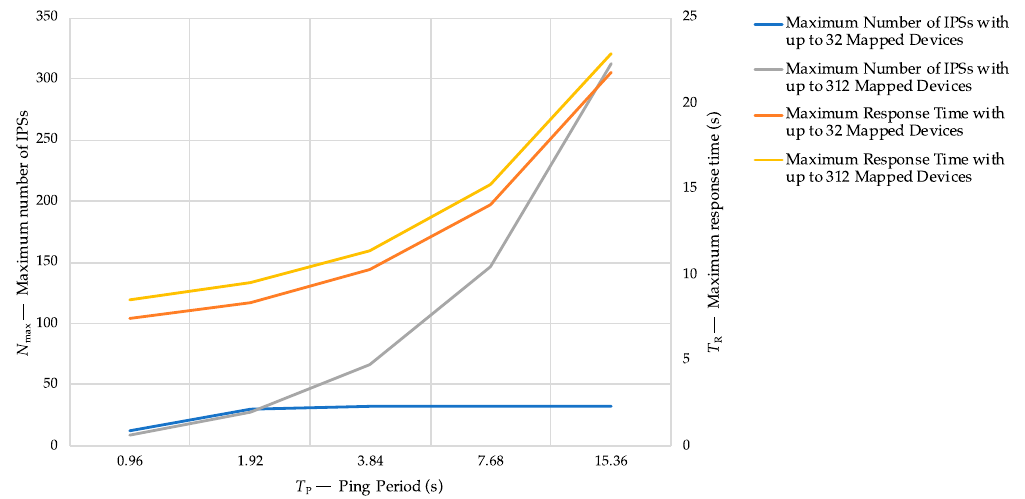
Figure 8. Estimation of the maximum number of IPSs that can be managed by (a single) LoRaWAN GWs and of the maximum expected response time depending on the ping period.